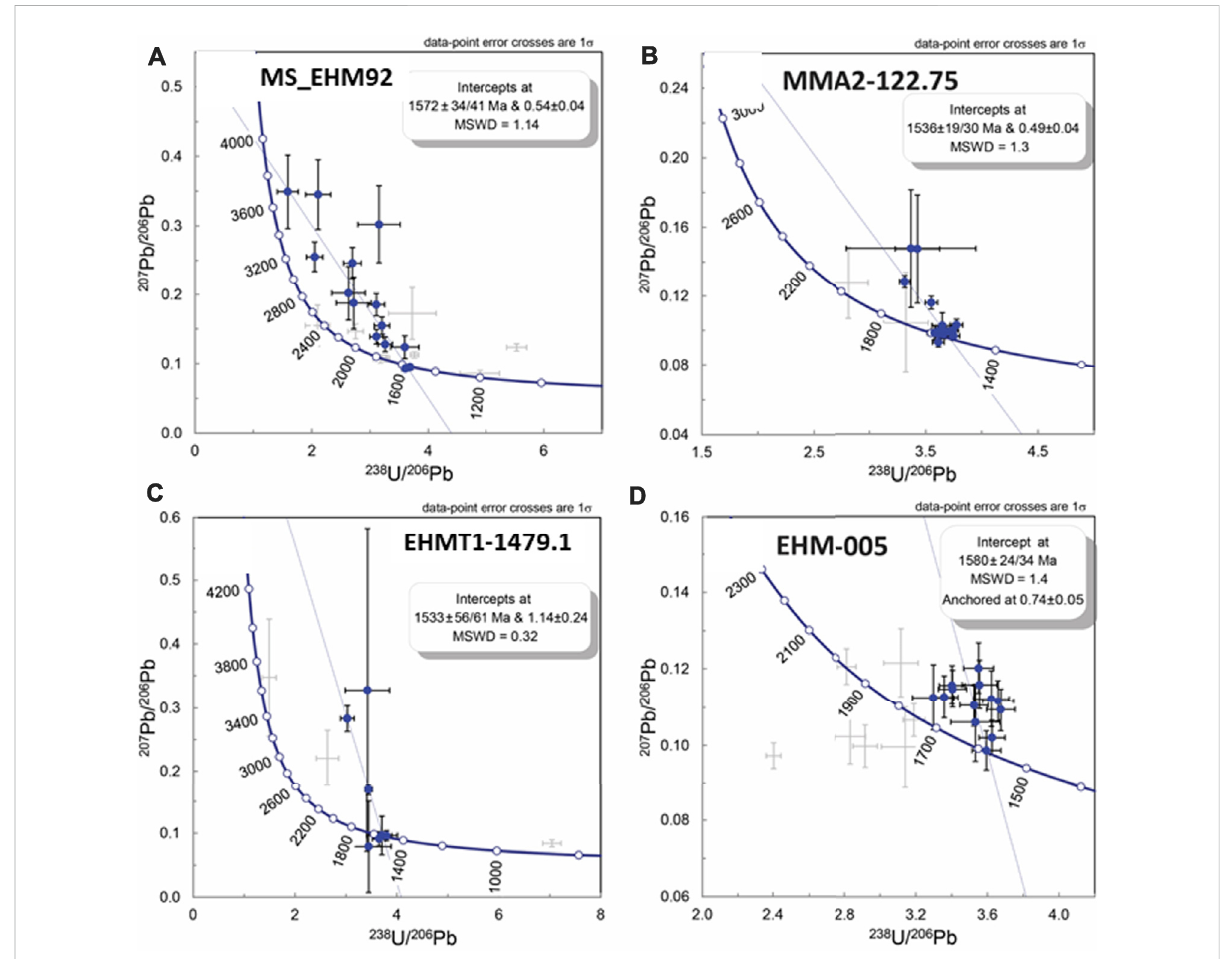
FIGURE 11 Uranium-Pb Tera-Wasserburg diagrams for apatite in samples MS_EHM-92, MMA2-122.75, EHMT1-1479.1, and EHM-005. Solid black error barswithbluecirclesareanalysesusedintheinterceptdatecalculation, whereasthegreyerrorbarsareanalysesnotusedduetoevidenceofPbloss oradditionofun-supportedradiogenicPb.Interceptdateuncertaintiesareinternal(analytical)followedbyfullypropagatedsystematicuncertainties. All samplesexcept EHM-005 are un-anchored isochronswiththeupperinterceptonthe 207 Pb/ 206 Pbaxis statedafter theinterceptage. Sample EHM-005 is anchored to a 207 Pb/ 206 Pb ratio of 0.74 ± 0.05.